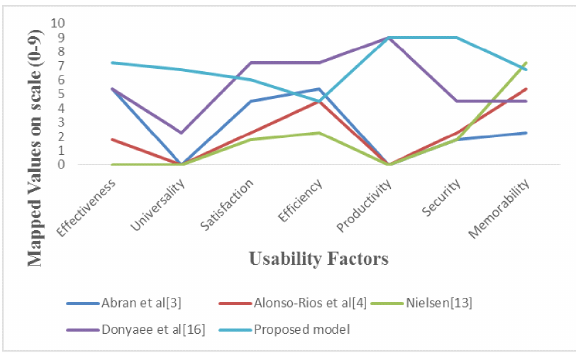
Figure 5: Detailed Comparison of the usability